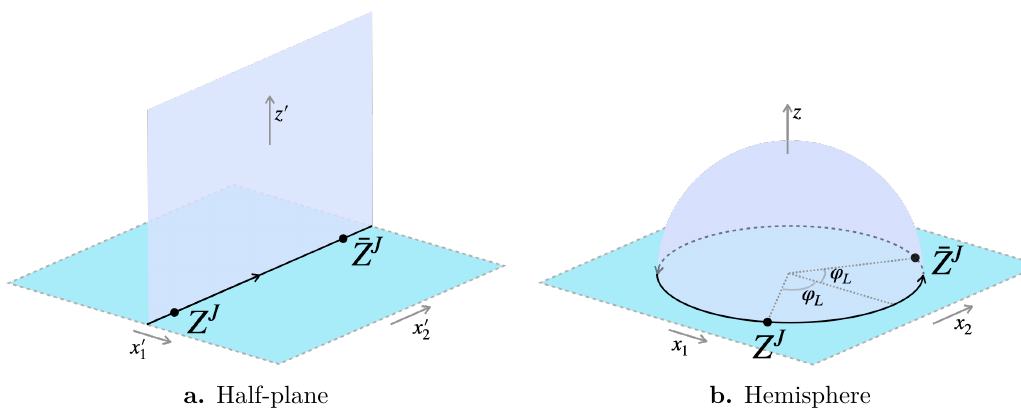
Figure 5 . The classical string solution in AdS global coordinates in figure 4 can be mapped to: a. a half-plane in Poincaré coordinates using eq. (4.10), in which case the string is dual to the Wilson line x 0 = 0 with Z J and ¯ Z J at x 0 = ∓ 1 ; or to b. the hemisphere in Poincaré coordinates using 1 2 eq. (4.11), in which case the classical string is dual to the Wilson loop x 2 at ϕ = ∓ ϕ L